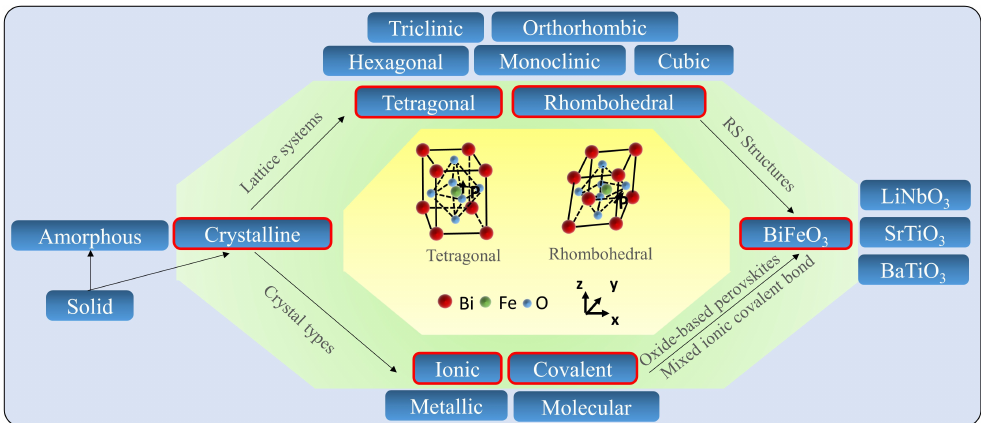
Figure 3. Schematic diagram of the relationship between lattice systems, crystal types, crystalline structures, and memristive devices with a specific focus on crystal symmetry and microstructure of BFO